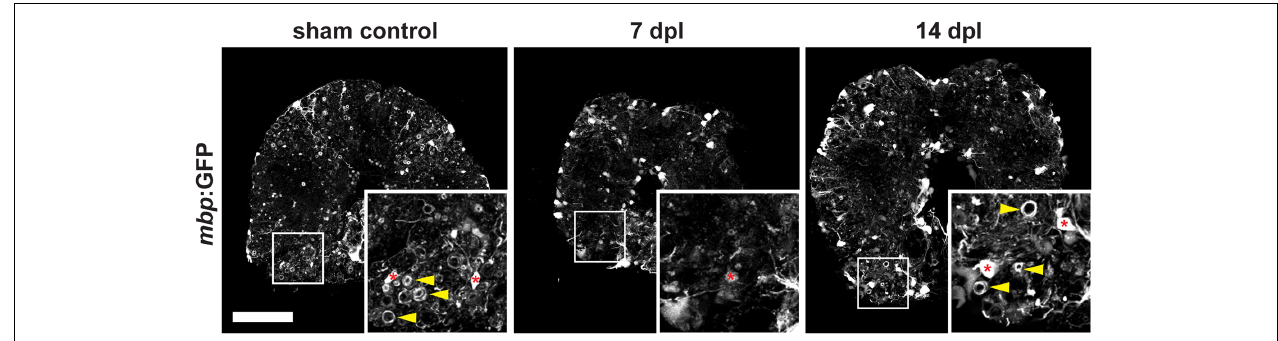
FIGURE 2 | Severe demyelination and loss of oligodendrocytes (red asterisks) occur until 7 days post spinal transection lesion (dpl) in the adult zebrafish spinal cord close to the site of injury. In contrast, in sham-lesioned control spinal cords many mbp :GFP-positive myelin sheaths are found (yellow arrowheads). At 14 dpl, a partial re-establishment of the constitutive myelination pattern is observed (yellow arrowheads). 50 µ m cross section; distance to lesion site ≤ 350 µ m; scale bar represents 100 µ m.